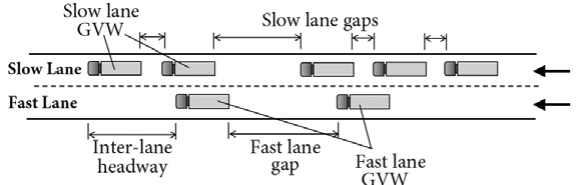
Fig. 1. Scenario Modelling validation procedure